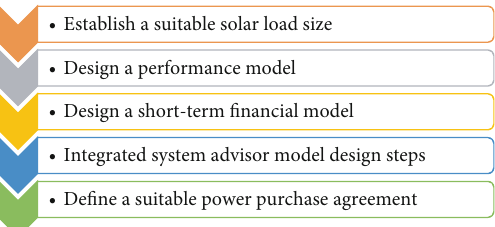
Figure 1: PV system modeling